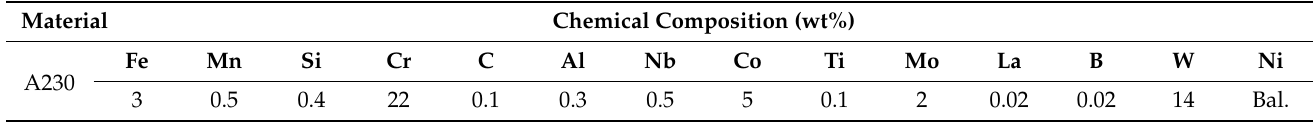
Table 1. Chemical composition of the A230 material.